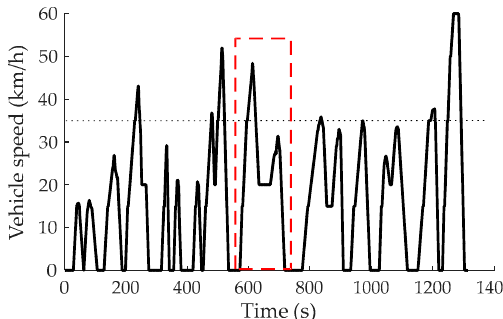
Figure 13. Bus speed in Chinese urban conditions.